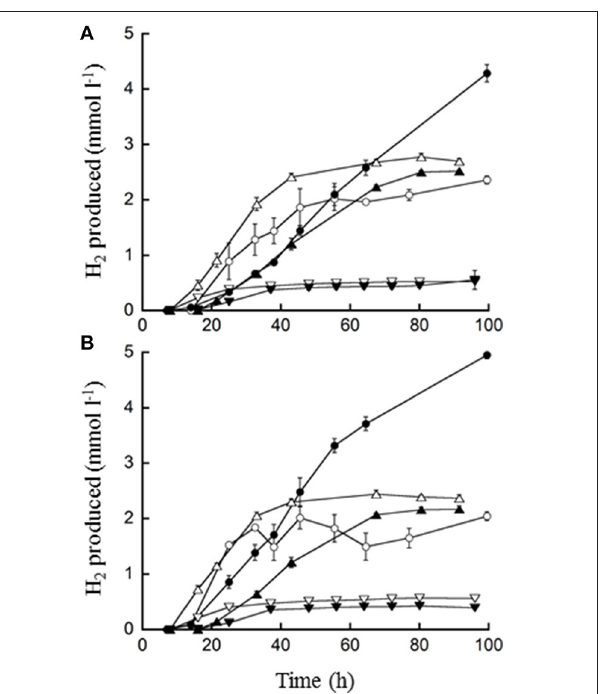
FIGURE 3 | H 2 production by T. paralvinellae (filled symbols) and P. furiosus (open symbols) when grown on waste milk from cows treated with Ceftiofur (A) and from untreated cows (B). The concentrations of ◦ • waste milk used were 10 ( , ), 1 ( 1, N ), and 0.1% ( ▽ , H ). Error bars represent the standard